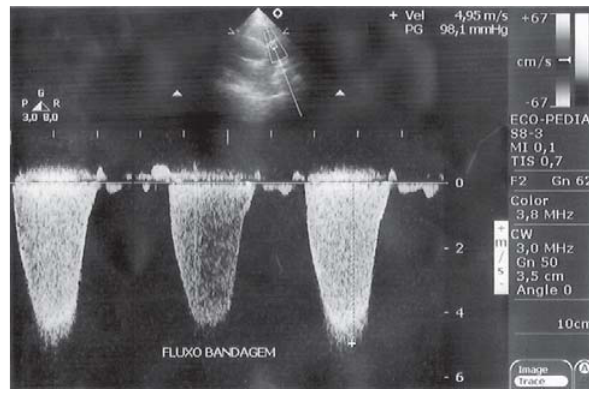
Fig. 3 – Traçado de Doppler contínuo mostrando gradiente sistólico pela bandagem do tronco pulmonar de 98